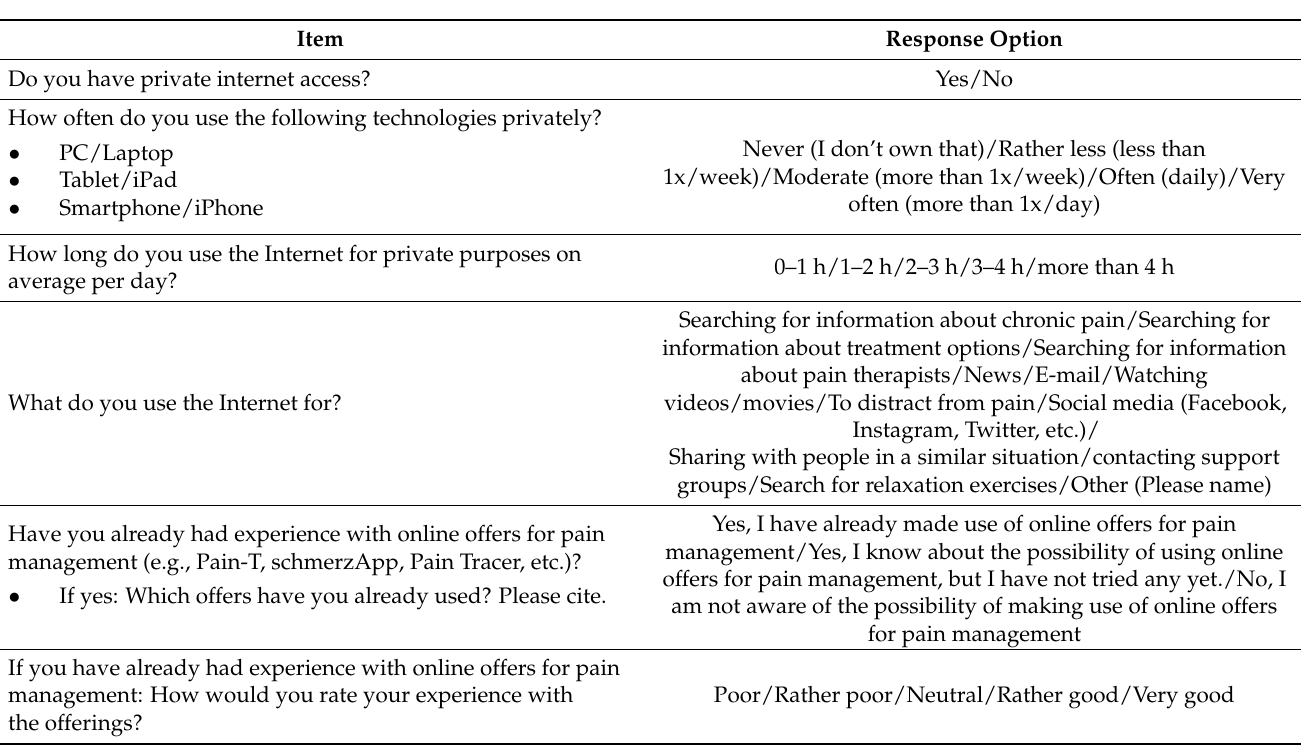
Figure A4. n = 338. The bars show absolute frequency (percentual frequency). Shown above are the participants’ responses regarding ( a ) the duration of an online offer for pain management; ( b ) one session’s length of an online offer for pain management.